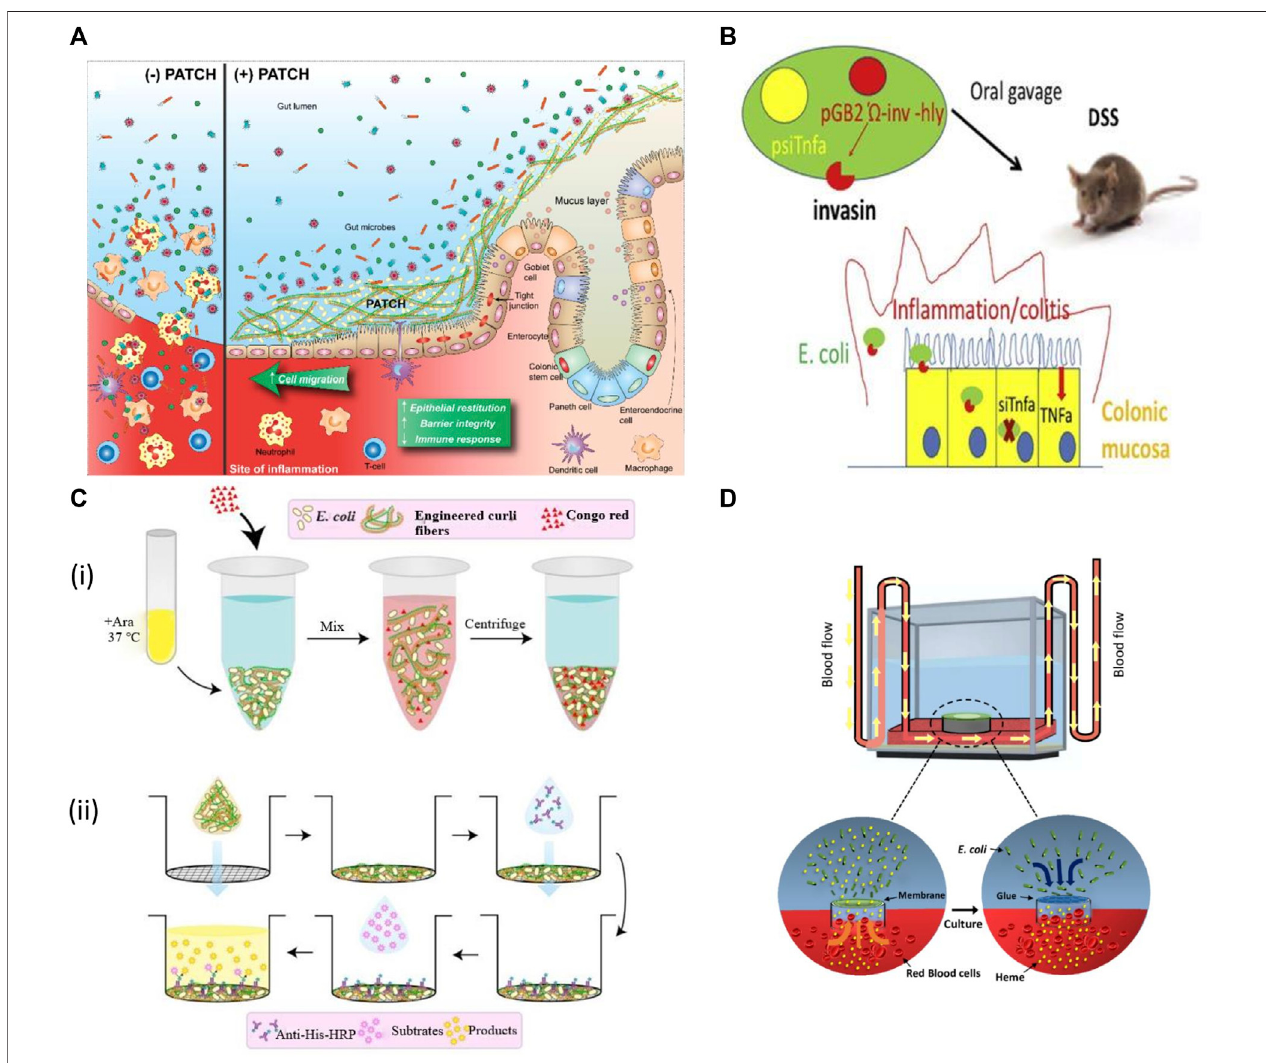
FIGURE 5 | Applications of engineered bacteria in IBDs. (A) Probiotic Associated Therapeutic Culi Hybrids (PATCH) and colonic mucosa interaction. IBD causes in fl ammatorywoundsthatresultindamagedepithelialtissue,lossofcolonicstructurewithlessbarrierintegrity(Patch − ).ThePatchapplicationproducescurli fi bersresult in enhanced intestinal barrier function, restitution of epithelial tissues, and lowers immune response to improve the IBD activity (Patch+). Reproduced with permission from Praveschotinuntet al.(2019),Copyright2019,SpringerNature. (B) Themodi fi edE.coliMDS42strain expressesinvasion proteinand listeriolysin Othathelps to invade and damage phagosomal membrane respectively. This process allows the plasmid deliveryencoding shRNA downregulates TNF. While the in fl ammation was also decreased in DSS-induced colitis. Reproduced with permission from Ferenczi et al. (2021), Copyright 2021, Elsevier. (C) (i) The curli fi ber variants produced from engineered E. coli Nissle at 37 ° C in LB media containing arabinose (Ara) measured by Congo Red Binding Assay. (ii) Illustration of the whole-cell fi ltration ELISA for measuringtheengineeredcurli fi bersproducedfrombacterialculture.ReproducedwithpermissionfromPraveschotinuntetal.(2019),Copyright2019,SpringerNature. (D) A living glue system enables repairing as it can sense heme coordination complexes and then respond by repairing the leakage sites within a micro fl uidic device